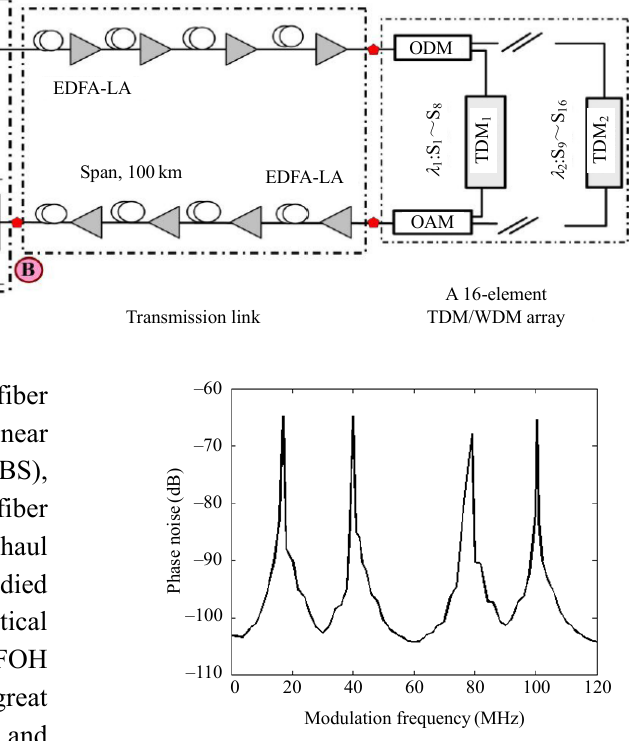
Fig. 13 Phase noise versus phase modulation frequency in [121].